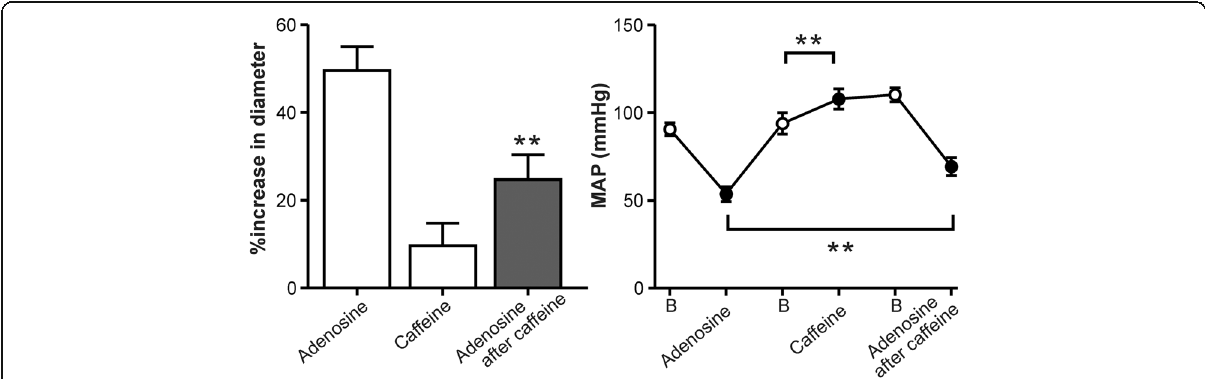
Fig. 2 The effect of caffeine on adenosine-induced dural vasodilation. Adenosine (1 mg/kg) was injected i.v. after a recovery period of 30 min. Then, caffeine (40 mg/kg) was injected slowly, and a second adenosine injection (1 mg/kg) was injected 15 min after the caffeine injection (adenosine after caffeine). Left panel illustrates increase in diameter and right panel changes in mean arterial blood pressure, in response to adenosine. Data are ± SEM, n =6, ** p <0.01 compared to the control. Open circles represent baseline measurements before injections,